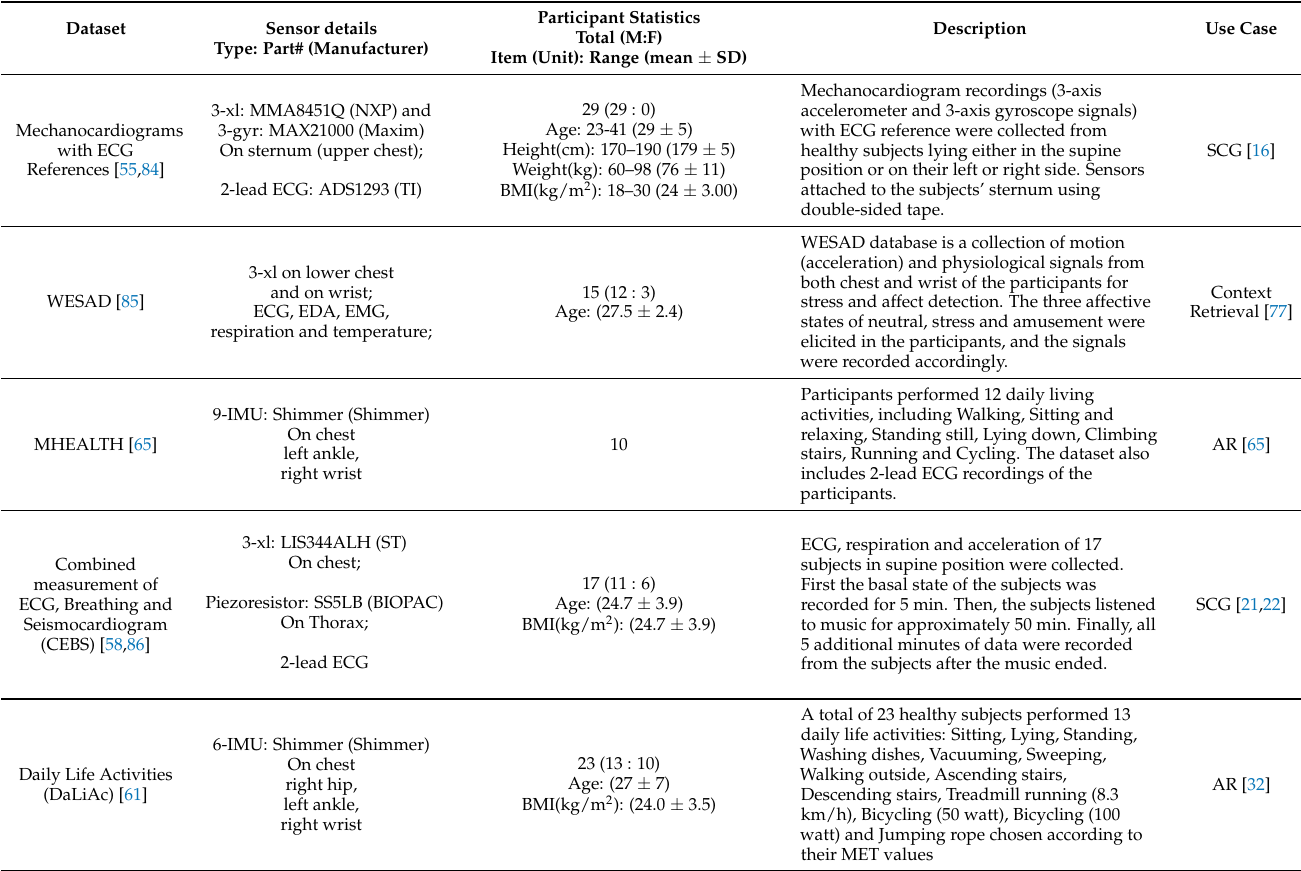
Table 9. Specifications of the datasets used in the referenced